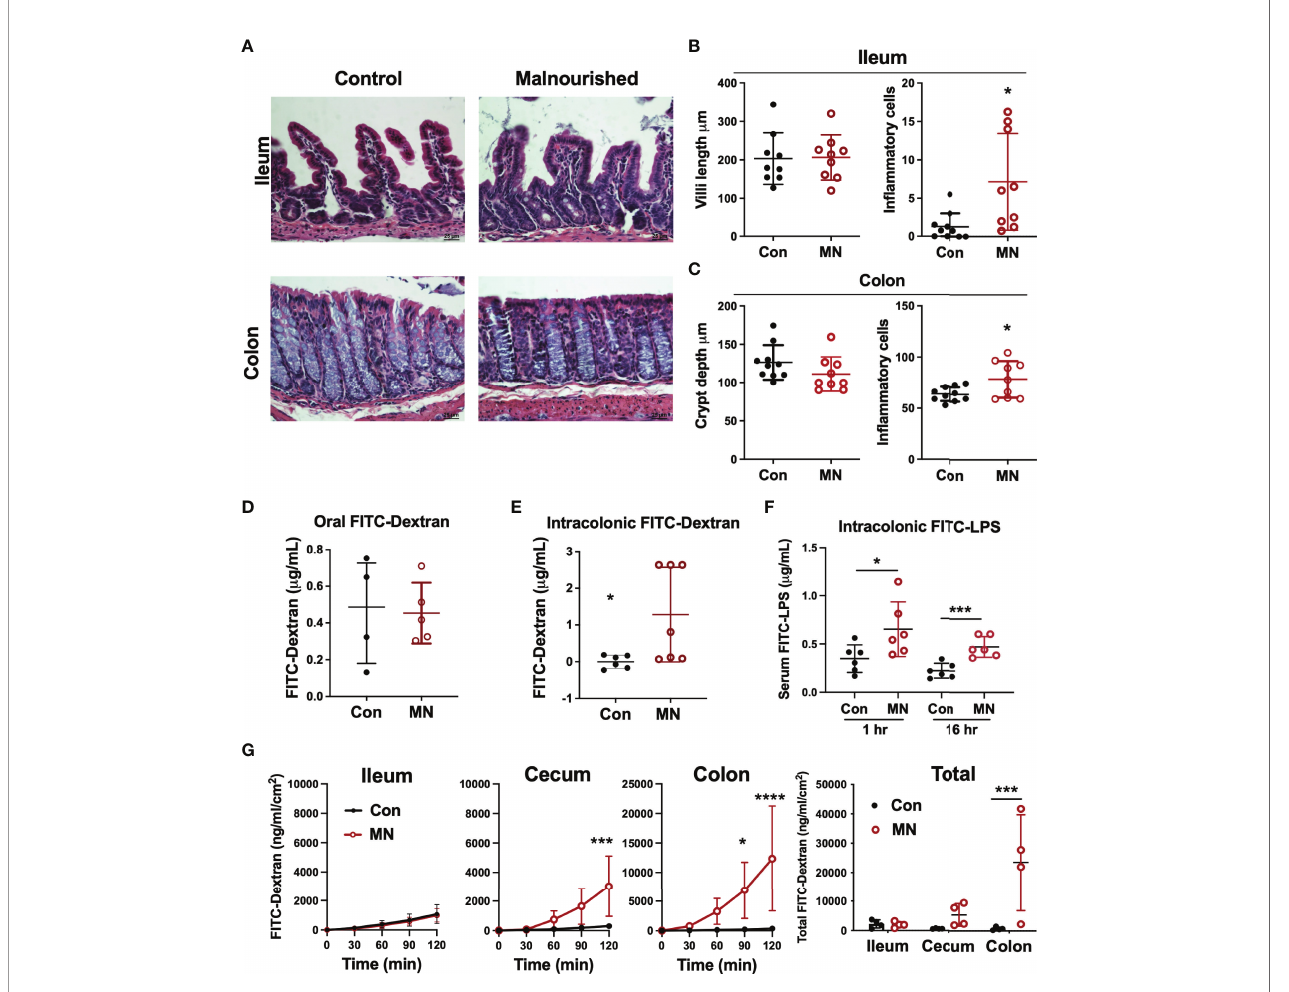
FIGURE 3 | Malnutrition promotes increased in fl ammation and permeability in the cecum and colon but spares the ileum. (A) Histopathology of ileum and colon in malnourished and well-nourished control mice. (B) Villus height and number of in fl ammatory cells in ileum of control (Con) and malnourished (MN) mice. (C) Crypt length and number of in fl ammatory cells in colon of control and MN mice. (D) Concentration of 4 kDa FITC-Dextran in serum of control and MN mice 1 hour after oral gavage. (E) Concentration of 4 kDa FITC-Dextran in serum of control and MN mice 1 hour after intracolonic delivery. (F) Concentration of FITC-LPS in serum of control and MN mice 1 hour and 16 hrs after intracolonic delivery. (G) Ex vivo paracellular permeability of intestinal epithelium from ileum, cecum, and colon (n=4 samples of each tissue) in control and MN mice over 2 hours diffusion in an Ussing diffusion chamber. Data are expressed as median with interquartile range of concentration over time measured in the basolateral side following delivery of 4 kDa FITC-dextran to the apical side of the intestinal epithelium of the ileum, cecum, and colon, and as composite fi gure where the data were normalized to the average measurements over all time points. (* p < 0.05; *** p < 0.001; **** p <